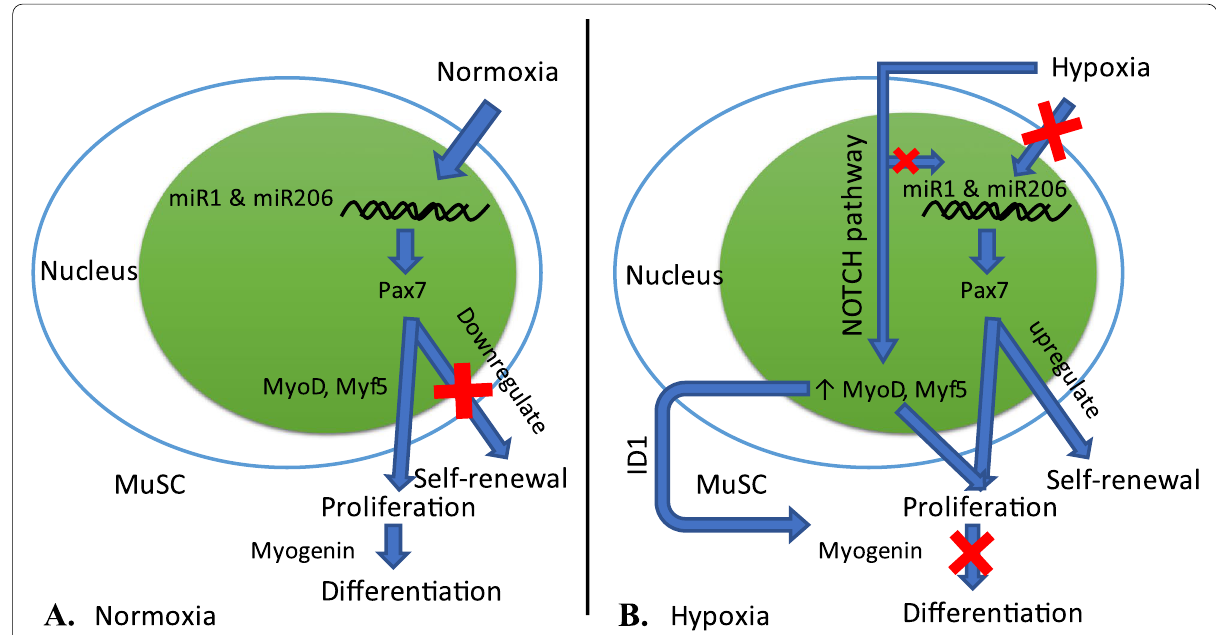
Fig. 3 The role of Pax 7 on the proliferation of skeletal muscle cells in the condition of A normoxia and B